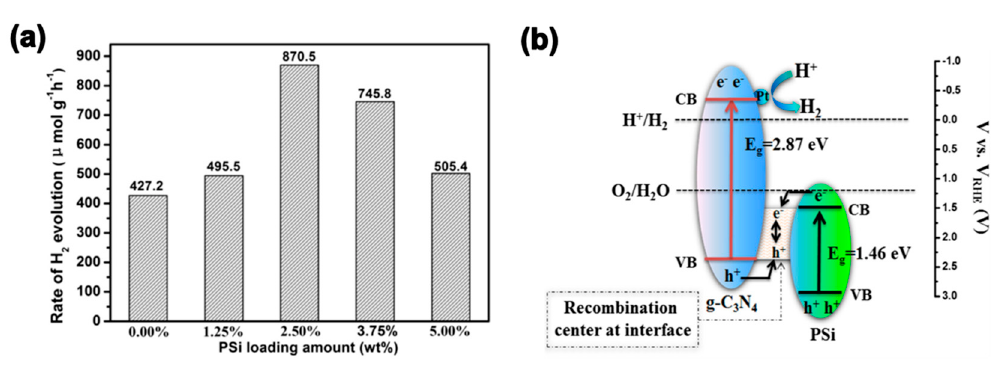
Figure 8. ( a ) Photocatalytic H 2 evolution with 100 mg pure g-C 3 N 4 and g-C 3 N 4 / PSi composite photocatalysts under visible light (400 nm) and ( b ) a schematic diagram of the g-C 3 N 4 / TiO 2 heterojunction system. Reproduced with permission from [81]; copyright (2017), Elsevier.